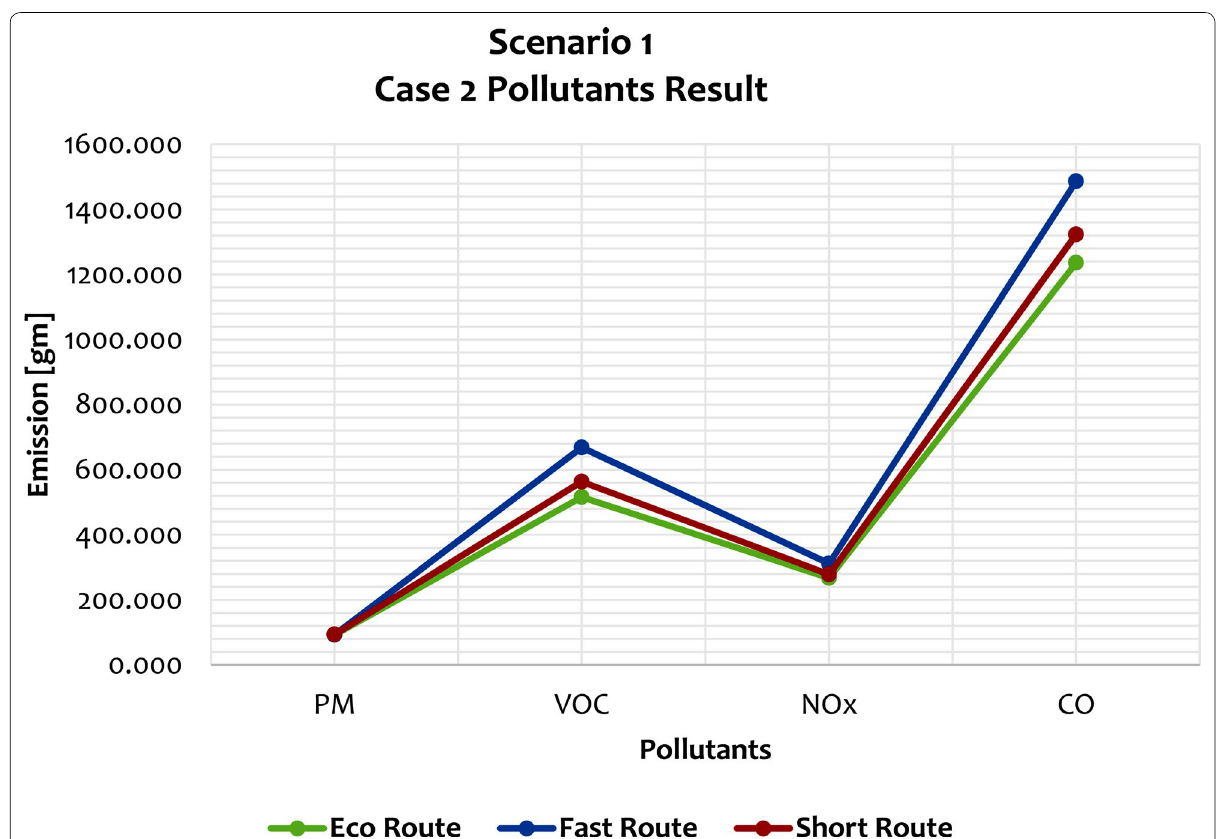
Fig. 15 Scenario 1 Case 2 pollutants emission results